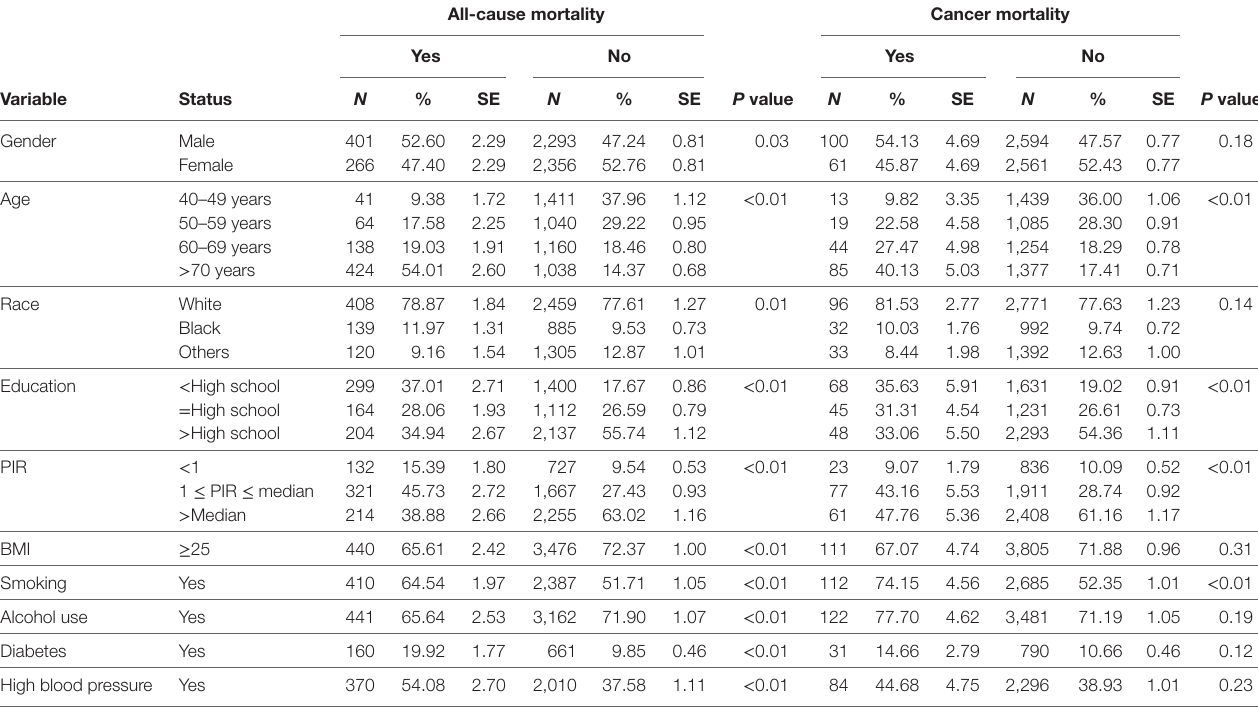
TaBle 2 | Weighted characteristics of the study population by mortality status-NHANES 1999–2010. all-cause mortality cancer